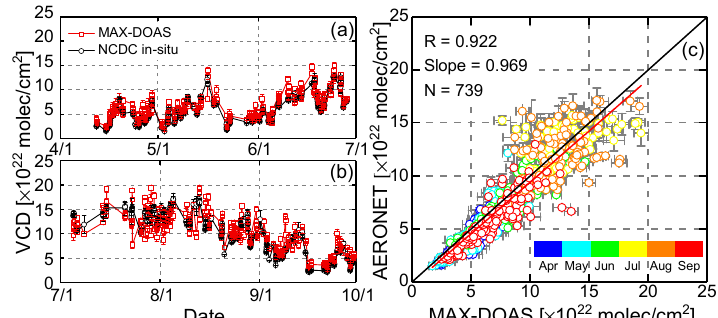
Figure 4. Comparison of the hourly averaged water vapor Vertical Column Densities (VCDs) retrieved from MAX-DOAS and AERONET. Panels ( a , b ) show two segments of the measurement time series (12 April–30 June 2018; 1 July–30 September 2018) of the hourly averaged water vapor VCDs derived from MAX-DOAS and AERONET. Panel ( c ) shows the correlation analysis of hourly averaged water vapor VCDs from MAX-DOAS and AERONET. All values are in units of molec / cm 2 .